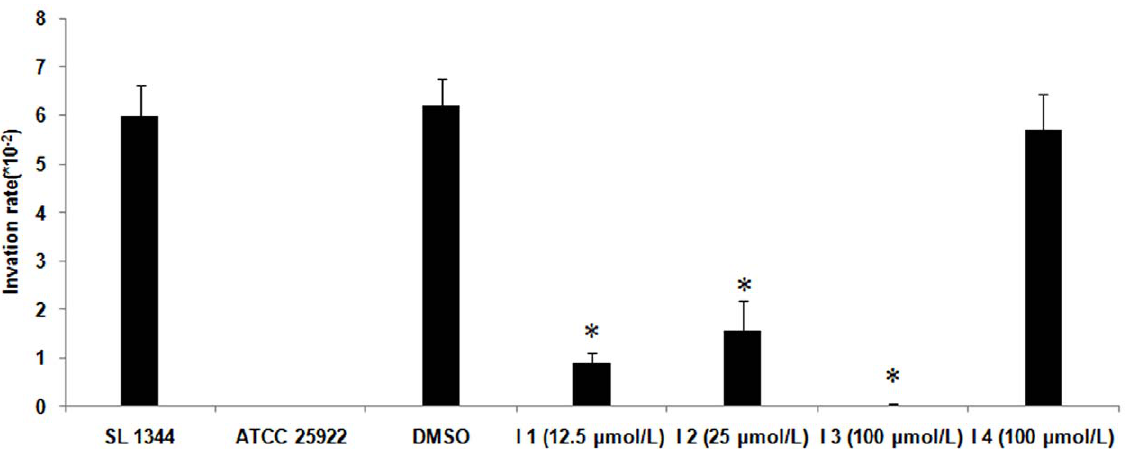
Figure 7. The effects of potential PhoQ inhibitors on cell invasion of Salmonella . The gentamicin protection assay shows the inhibitory effect of the four potential PhoQ inhibitors on Salmonella enterica typhimurium SL 1344 HeLa cells invasion. The bacteria pre-treated with potential PhoQ inhibitor were added to HeLa cells at a multiplicity of infection of 100. Then gentamicin was added to kill extracellular bacteria and cell lysates were plated onto LB plates, and the colonies were counted. The results of the assays were expressed as the number of bacteria recovered from gentamicin-treated cells divided by the number of inoculated bacteria added to the cell. Salmonella enterica typhimurium SL 1344 served as the positive control for the cell invasion assay; E. coli ATCC 25922 (treated without DMSO), an avirulent strain, served as the negative control for the cell invasion assay; bacteria treated with 0.1% DMSO also served as a control for the cell invasion assay. Values are means 6 standard deviations from 6 independent wells. *p , 0.01 vs. SL